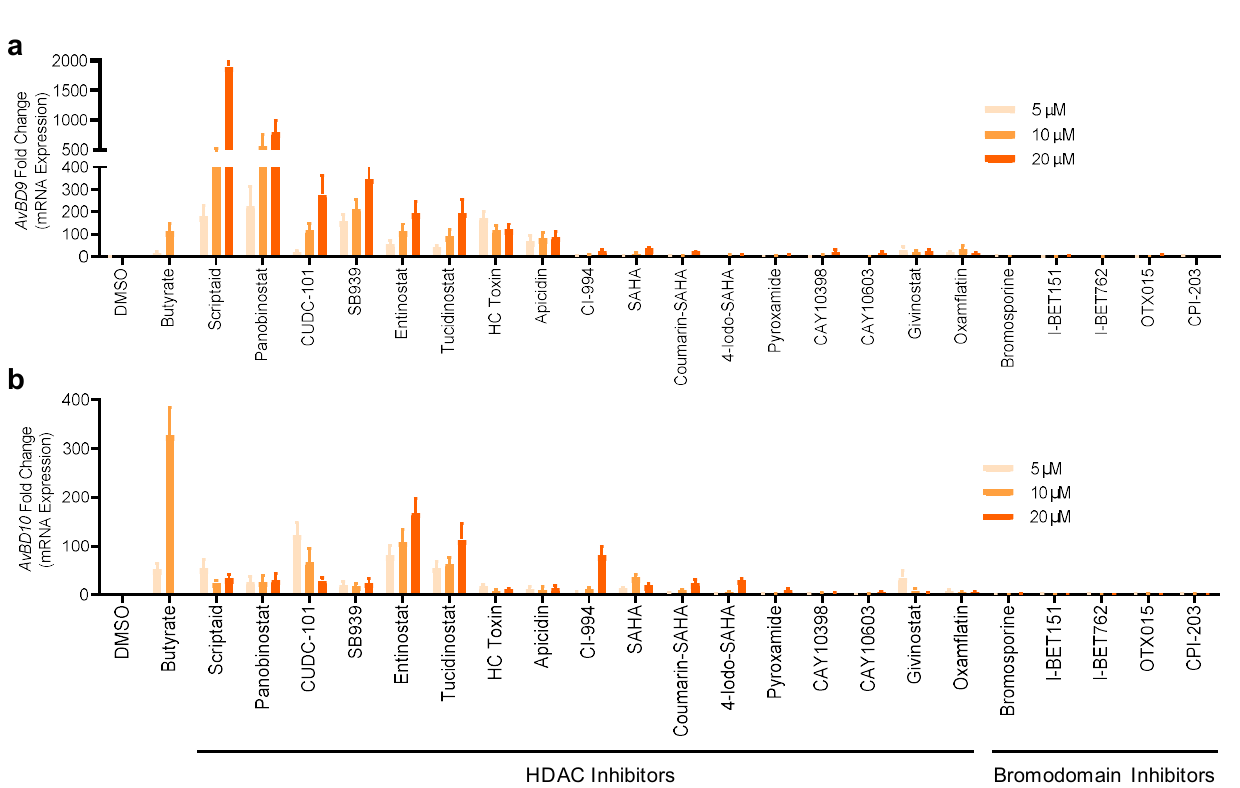
Figure 4. Induction of the AvBD9 and AvBD10 mRNA expression by 22 selected compounds in chicken HTC macrophages. HTC cells were stimulated in duplicate with three concentrations (5, 10, and 20 µM) of each compound for 24 h, followed by RT-qPCR analysis of the AvBD9 ( a ) and AvBD10 ( b ) mRNA expression. HTC cells treated with 2- and 4-mM butyrate were used as positive controls. Fold changes in HDP mRNA expression were calculated relative to DMSO-treated cells using the ΔΔCt method. The results are means ± SEM of 3–4 independent experiments.